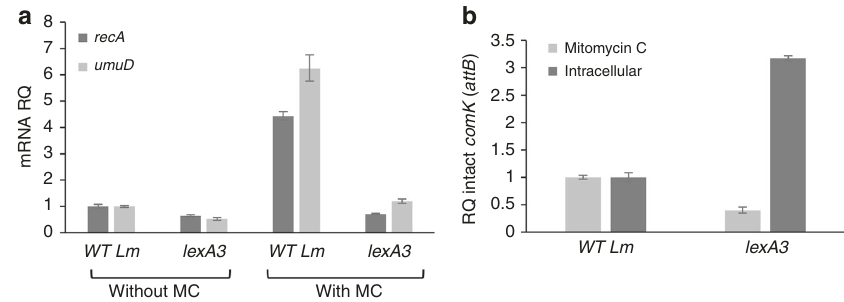
Fig. 5 The role of the SOS response in MpaR activation. a qRT-PCR transcription analysis of SOS response representative genes ( recA and umuD ) in WT bacteria and bacteria harboring lexA3 mutation, with and without MC treatment at 30 ˚ C. Transcription levels are presented as relative quantity (RQ), relative to their levels in untreated WT bacteria. The data represents three independent experiments. Error bars indicate a 95% con fi dence interval. b qRT- PCR transcription analysis of intact comK gene ( attB site) in WT bacteria and bacteria harboring the lexA3 mutation upon MC treatment or during intracellular growth in macrophages (6 h post infection). attB levels are presented as relative quantity (RQ), relative to their levels in WT bacteria. The data represents three independent experiments. Error bars indicate a 95% con fi dence interval. Source data are provided as a Source Data fi le.